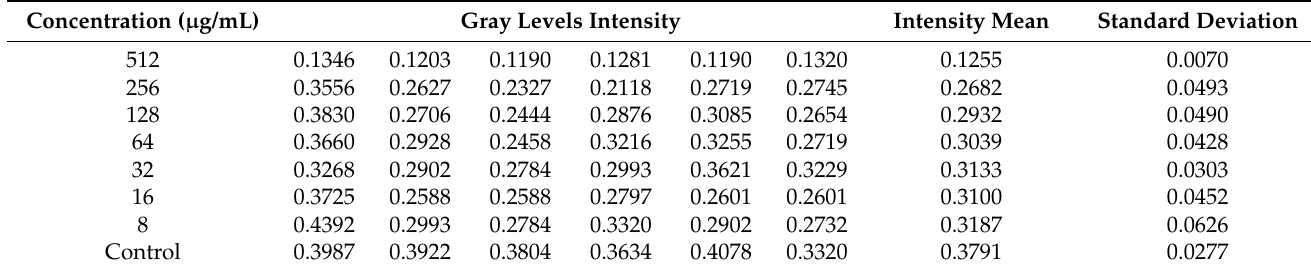
Table 2. The 1199 strain—Gray levels intensity after the addition of resazurin.